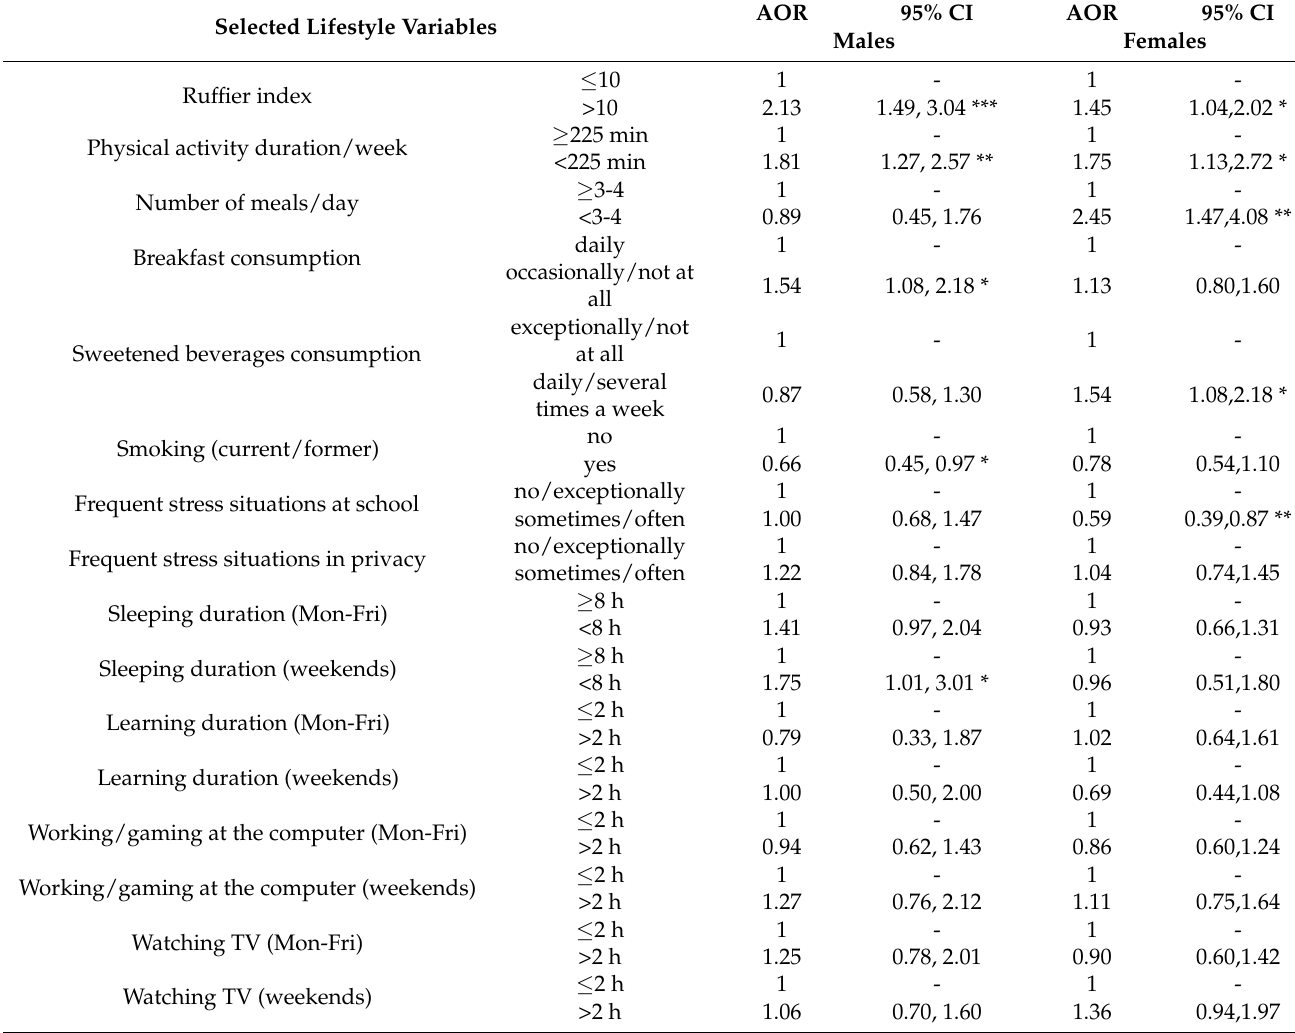
Table 4. Selected lifestyle variables (acceptable vs. risky) associated with insulin resistance (defined according to HOMA-IR) in males (n = 1205) and females (n = 1424)—multivariate logistic regression